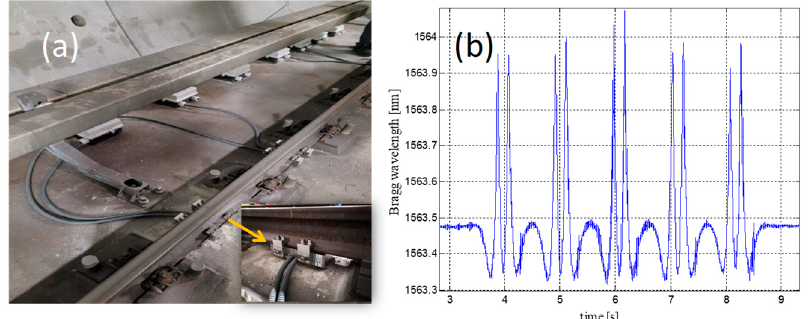
Figure 9. WIM–WILD in-field installation photo ( a ) and typical FBG waveform [133] during a passing train ( b ).